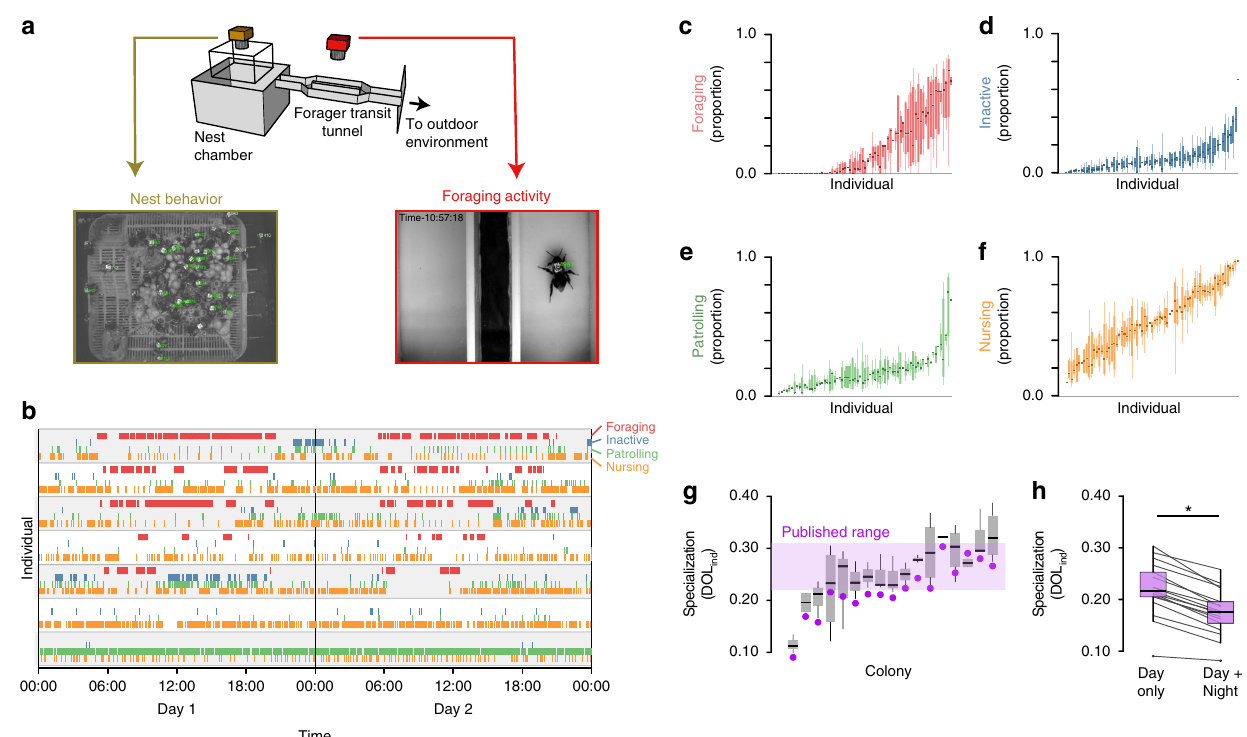
Fig. 1 Automated behavioral tracking and task classi fi cation in bumble bee colonies. a Schematic diagram (above) and sample images from within the nest (left, orange) and the foraging tunnel (right, red), showing tracked individual BEEtags in green. b Representative traces of task performance from seven individual bees over 2 days from a single colony. Vertical lines indicate timesteps during which bees were foraging (F, red), inactive (I, blue), patrolling/ cleaning (P, green), or nursing (N, orange). c – f Proportion of time spent engaged in different tasks by individual workers from the same representative colony. Boxplots in c – f show values for individual workers. Individuals are ordered in each plot according to the mean proportion of time spent performing that task. g Worker specialization (DOL ind ) values by colony. Filled purple markers show total estimates of each metric for each colony (i.e., combining data from all experimental days) and purple shaded box shows the range of published values across four colonies from the same species using manual task classi fi cation 61 . Gray boxplots show data when division of labor metrics are calculated for each experimental day separately. h Purple boxplots show total worker specialization values for each colony when only task performance from daytime hours is considered ( “ Day only ” ), vs. when round-the-clock data are included ( “ Day + Night ” ). Gray lines connect values for individual colonies. Throughout, boxplots show the median and inter-quartile range (IQR), while whiskers depict the data range (75th and 25th ±1.5*IQR,